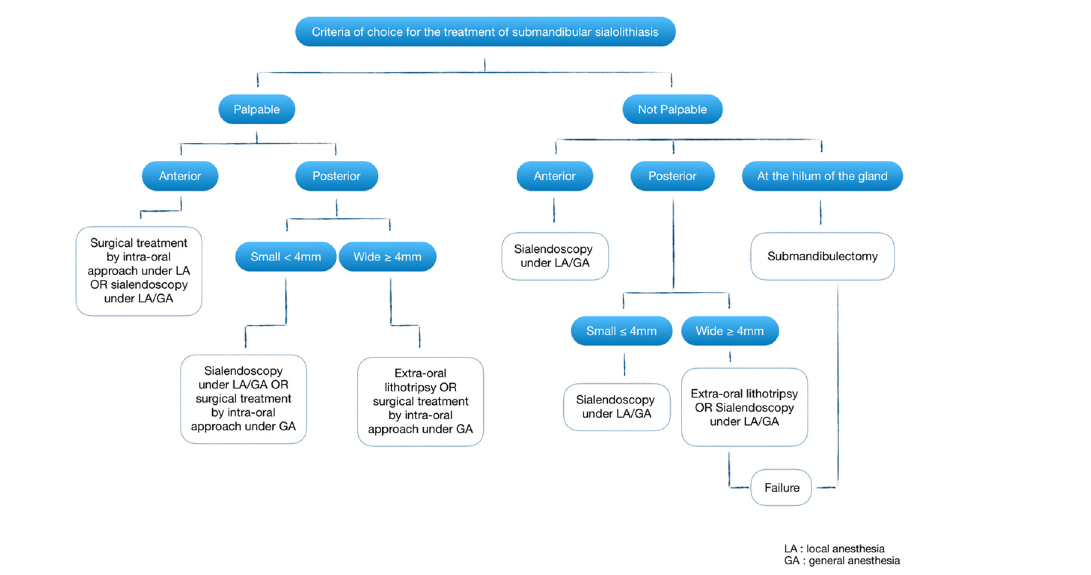
Table II. Criteria of choice for the treatment of submandibular